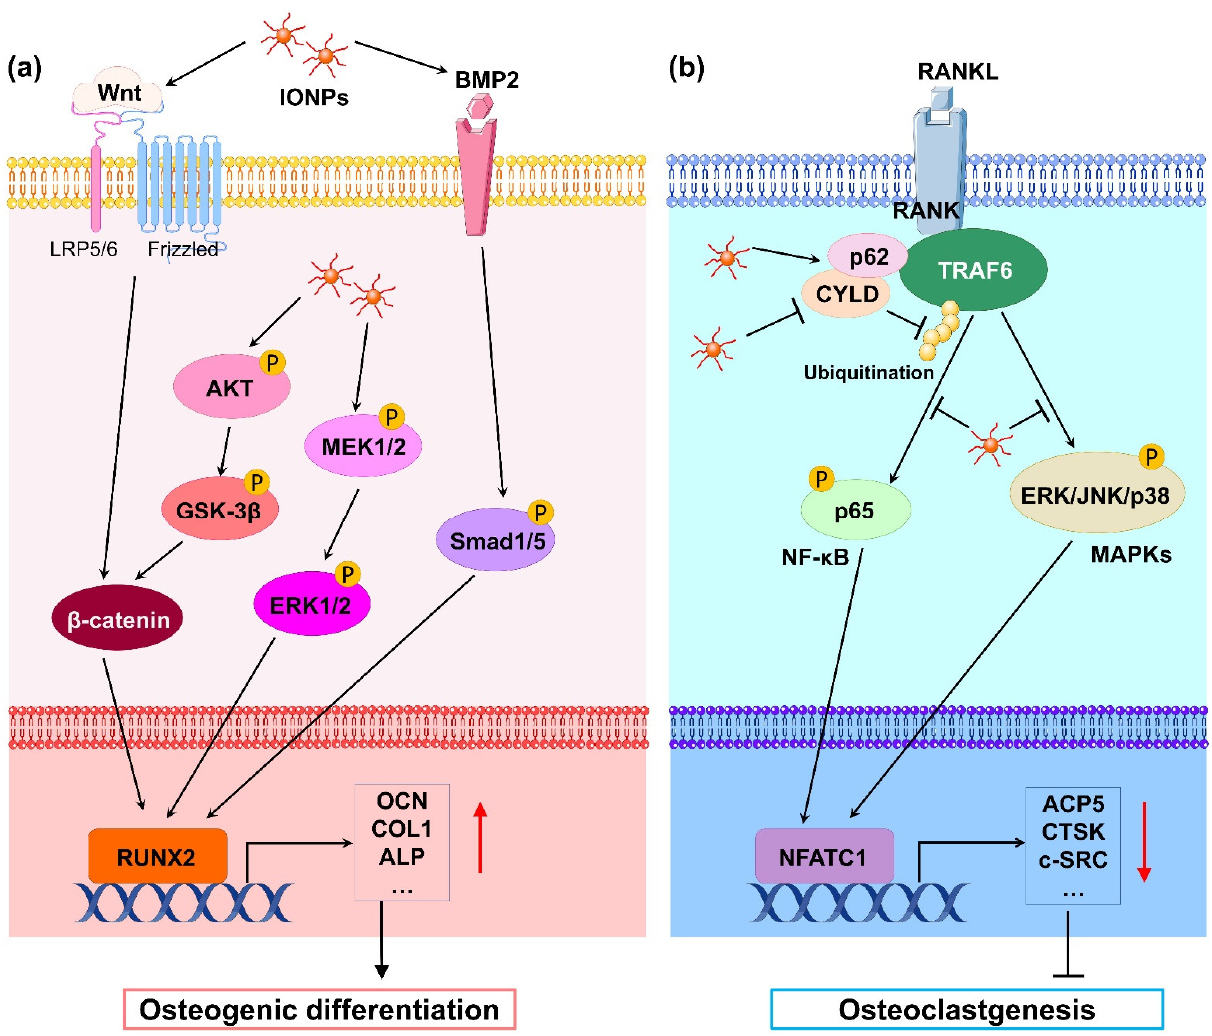
Figure 1. ( a ) Schematic illustration of IONP-promoted osteogenic differentiation in osteoblasts and stem cells. Classical Wnt/β-catenin, Akt-GSK-3β-β-catenin, MAPK, and BMP-2/Smad signaling pathways are activated by IONPs. Thus, osteoblastogenesis-related gene transcription downstream